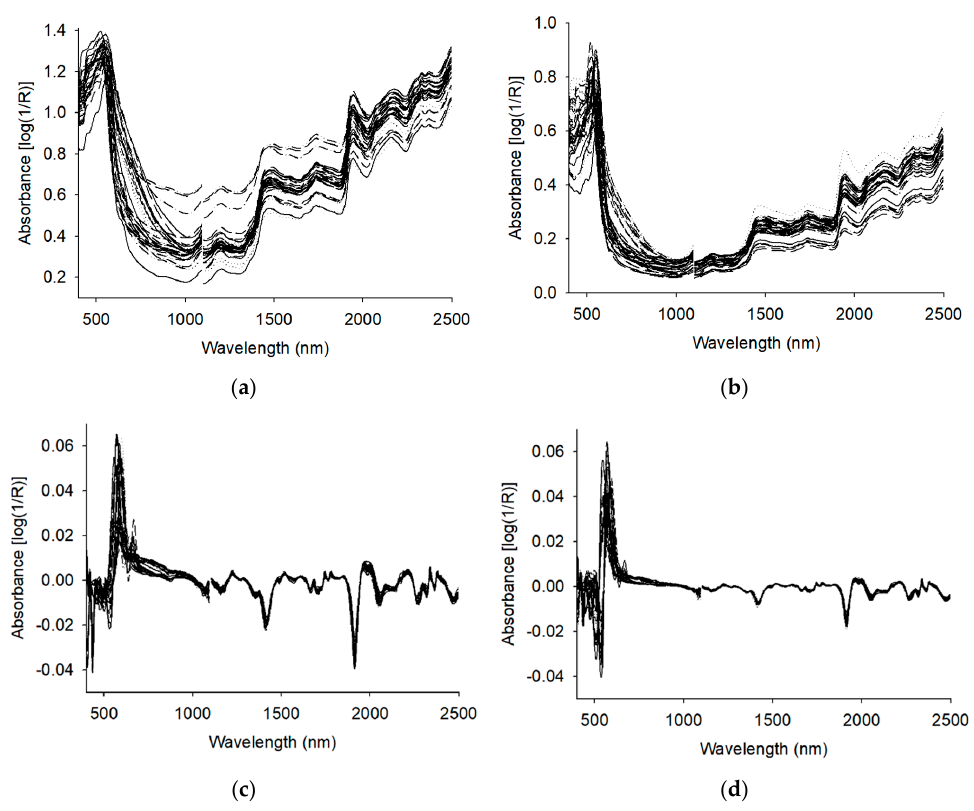
Figure 1. The visible/near-infrared full-wavelength spectra: ( a ) raw spectra of tea leaves, ( b ) raw spectra of tea powders, ( c ) first derivative spectra of tea leaves, and ( d ) first derivative spectra of tea powders.